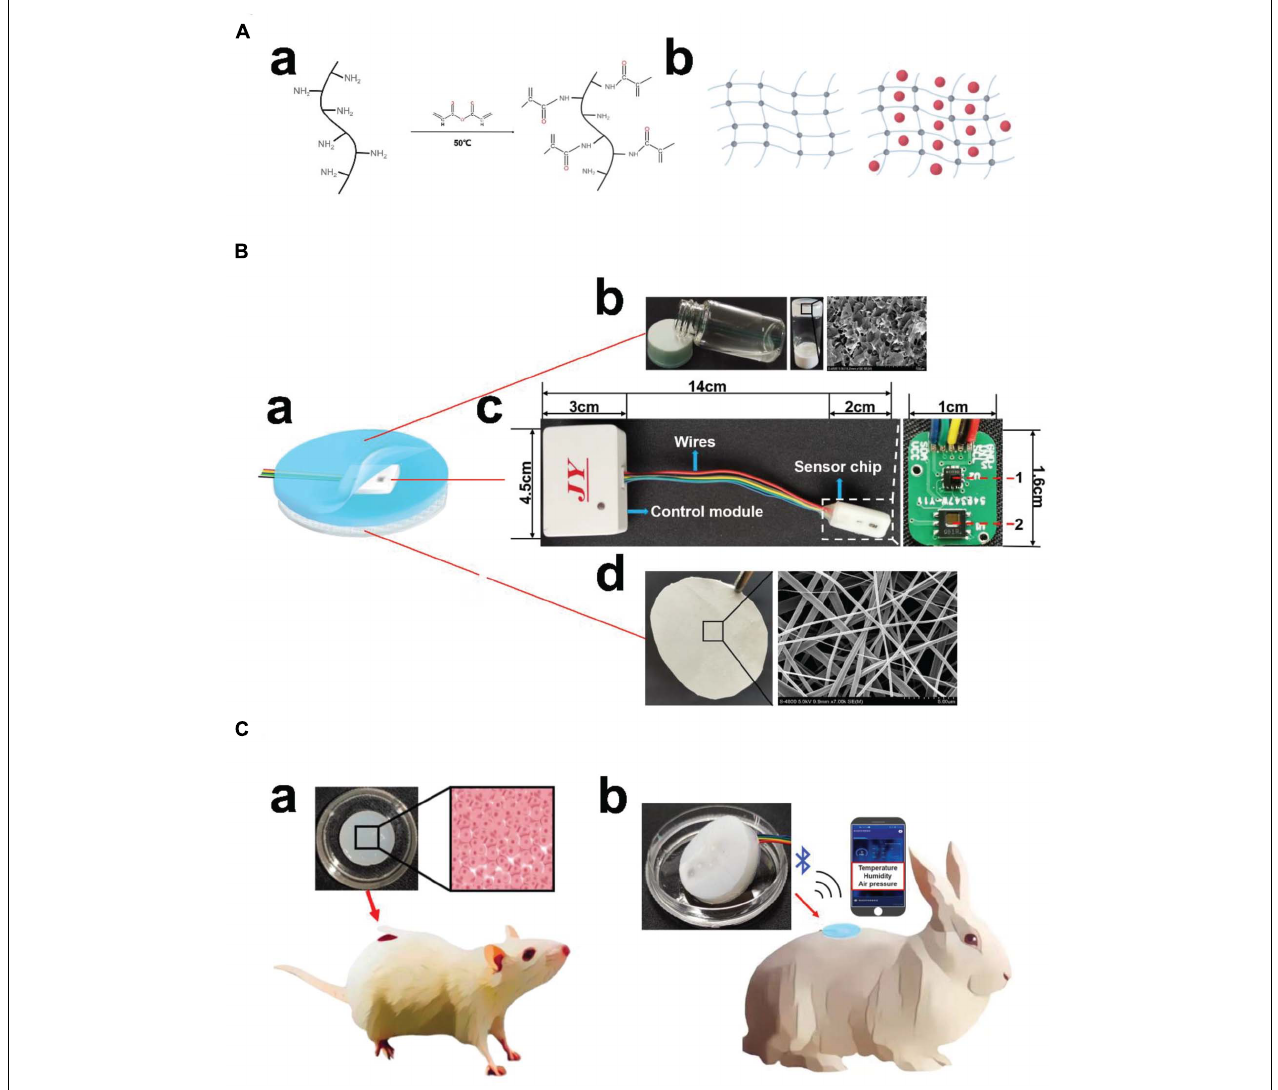
FIGURE 1 | Structures and application scenario of the integrated smart dressing. (A) Schematic diagram of GelMA synthesis. (a) Gelatin undergoes a functionalization process using methacrylic anhydride with methacrylate and methacrylamide groups to form gelatine methacryloyl (GelMA). (b) Network structure of the GelMA hydrogel and β -cd in the GelMA hydrogel. (B) Schematic diagram of the integrated smart dressing structure. (a) The integrated smart dressing includes a microenvironment sensor, biomimetic nanofibre membrane and GelMA + β -cd UV crosslinked hydrogel. (b) Physical and detailed diagram of the prepolymer and crosslinked hydrogel. (c) Detailed diagram of the microenvironment sensor. (1, air-pressure sensor; 2, temperature and humidity sensor) (d) Photograph and detailed diagram of the biomimetic nanofiber membrane. (C) Physical diagram of the integrated smart dressing and schematic diagram of the animal experiment. (a) In vivo degradation and pro-angiogenic effect of the hydrogel. (b) In vivo monitoring and pro-healing effect of integrated smart